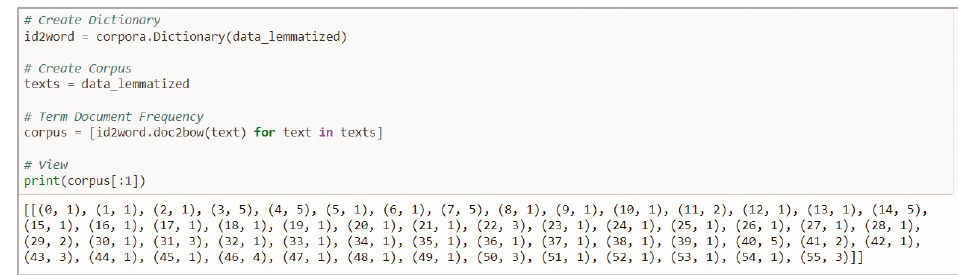
Figure 4. Code 2: Recognizing main topics, own elaboration.